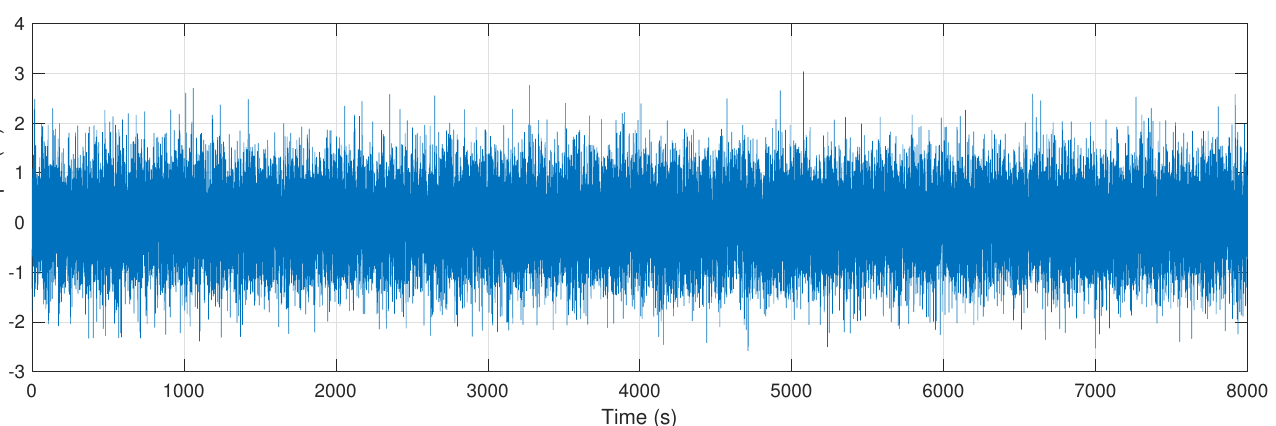
Figure 3. Wave elevation as white